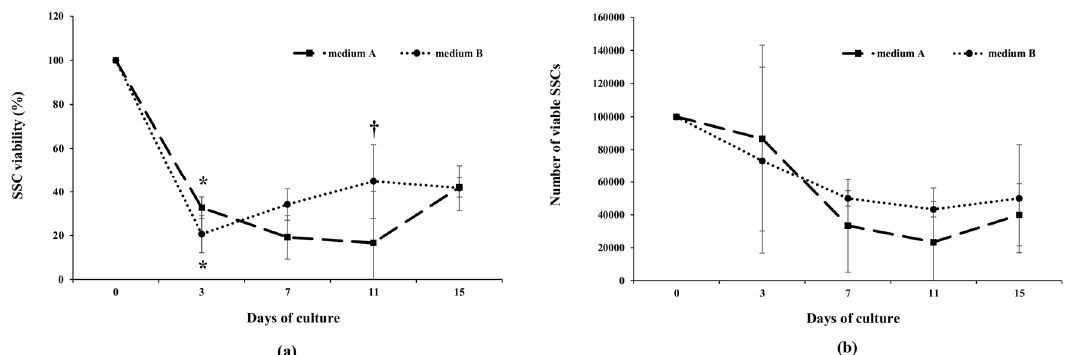
Figure 4. Viability ( a ) and proliferation rate ( b ) of meagre spermatogonial stem cells (SSCs) cultured